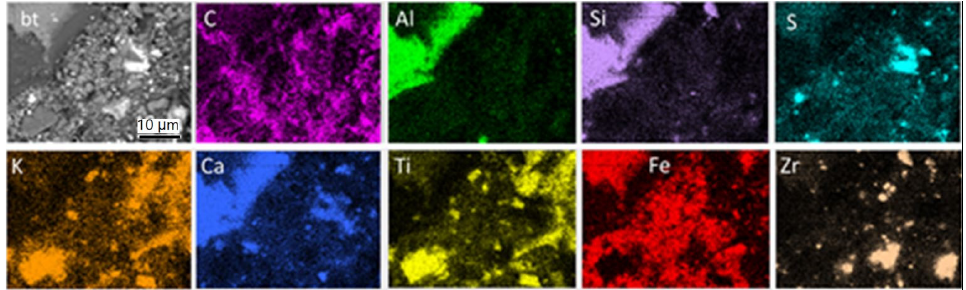
Figure 7. SEM-BSE image (grey) and element mapping illustrating the element distribution on the used brake pad surface. (bt): braking trace. Untreated sample, top